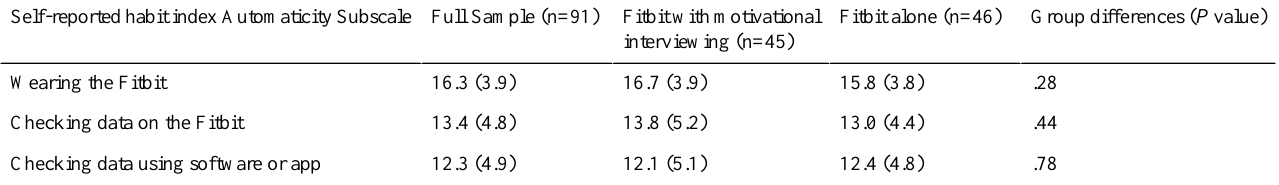
Table 4. Descriptive statistics (mean [SD]) for the Automaticity Subscale of the Self-Reported Habit Index.